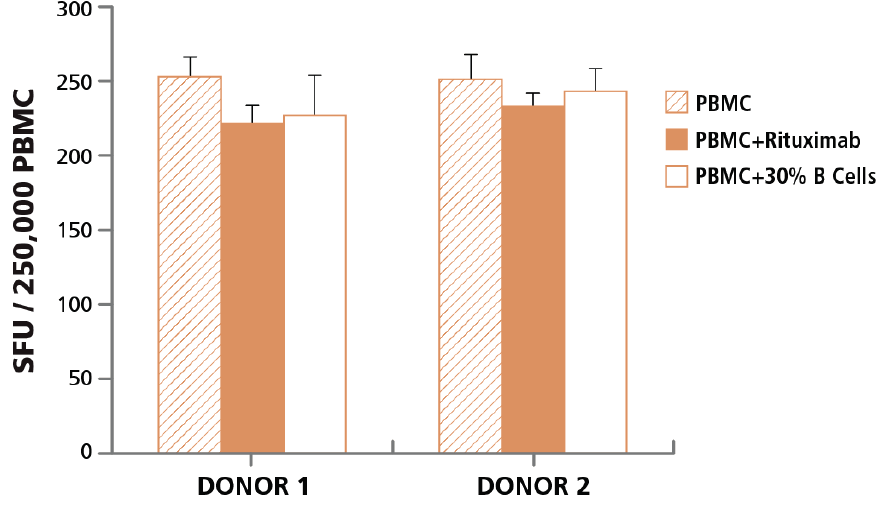
Figure 4. Cell-to-Cell contact of T cells with apoptotic B cells does not affect T cell activation. The specified two PBMC donors were tested in a human IFN- γ ELISPOT assay with CEF peptide pool added to activate CD8 cells (hatched bars). The PBMC were tested in parallel with anti-CD20 monoclonal antibody added to the wells during the ELISPOT assay (closed bars). To increase the number of apoptotic cells, B cells from the